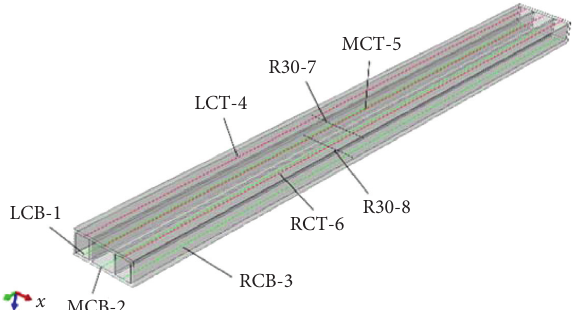
Figure 10: Monitoring line arrangement in the utility tunnel.